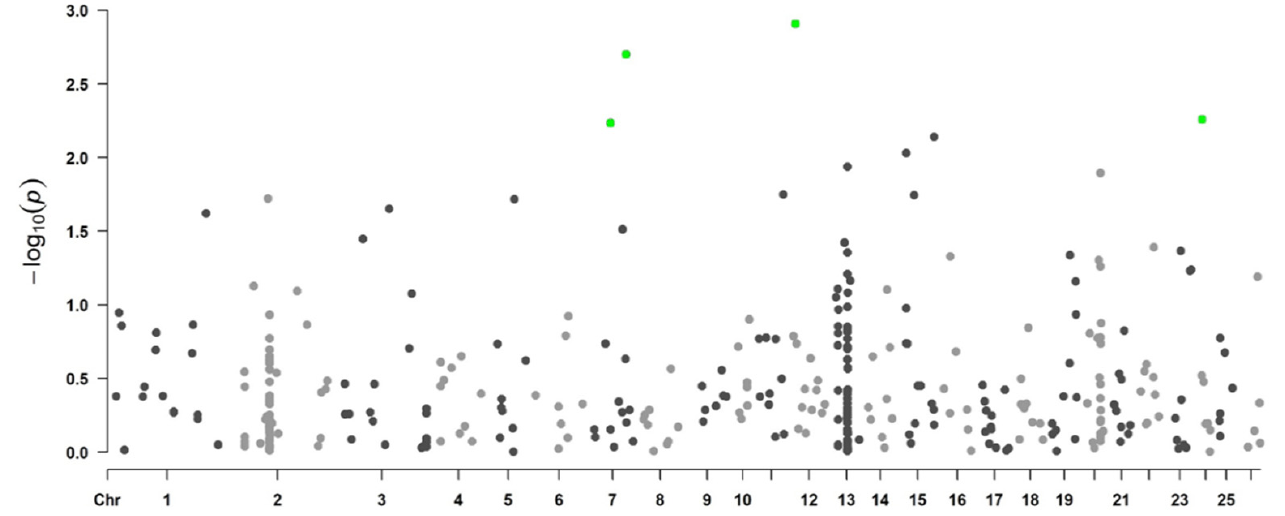
Figure 4. Manhattan plot representing genome-wide associations with logFEC using the 507 SNP chip and 702 genotyped individuals. Y -axis shows each SNP − log 10 ( p -value) and x -axis shows the SNP position across the 26 chromosomes. Green dots represent the significant SNPs using a chromosome-wise FDR of 5%, black and gray dots are non-significant SNPs.